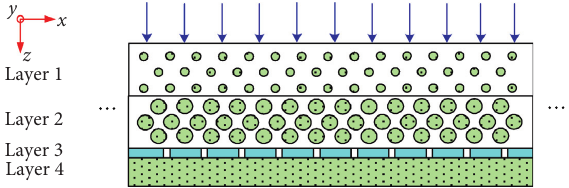
Figure 1: Cross section of the proposed matching